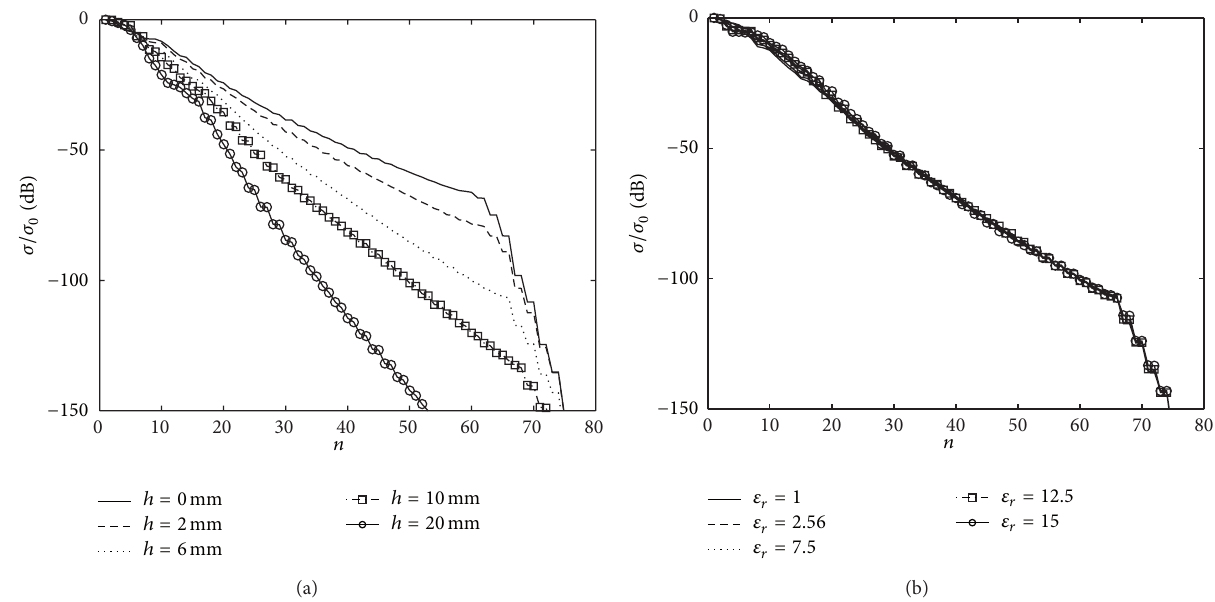
Figure 5: SVD analysis of the effect of the compression plates. (a) Thickness variation with 𝜀 𝑟 = 2.56 and 𝜎 = 0.005 S / m. (b) Permittivity variation with thickness set to